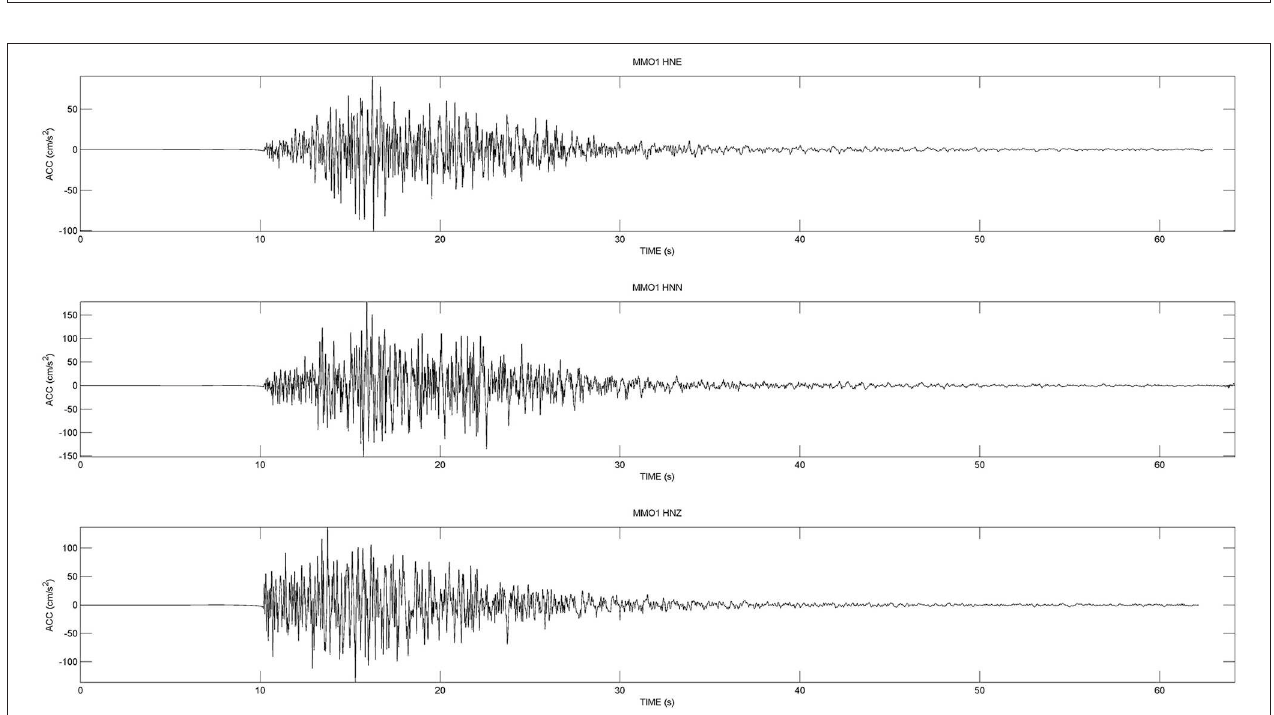
FIGURE 7 | Accelerometric signal recorded during the main seismic event Mw 6.5 earthquake 30th October 2016, 06:40:17 in Central Italy. The waveform was recorded at MMO1 station, 21.7km away from hypocentre, by MEMS sensor.